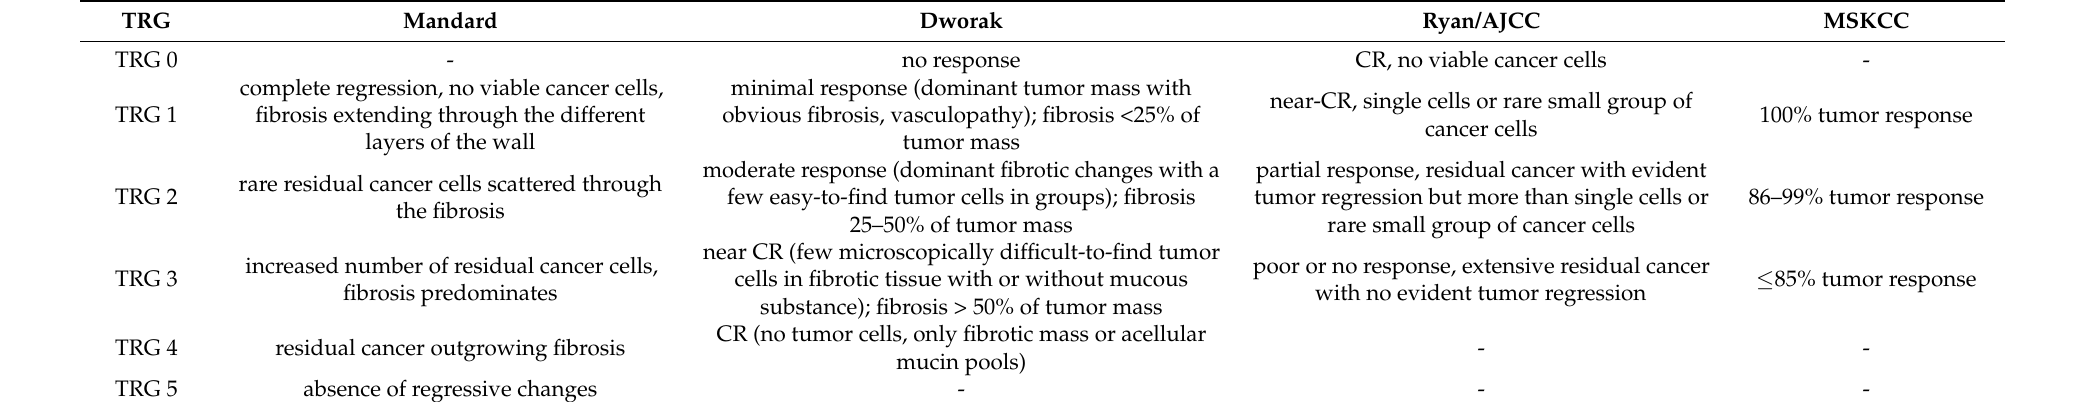
Table 2. Most common TRG classification